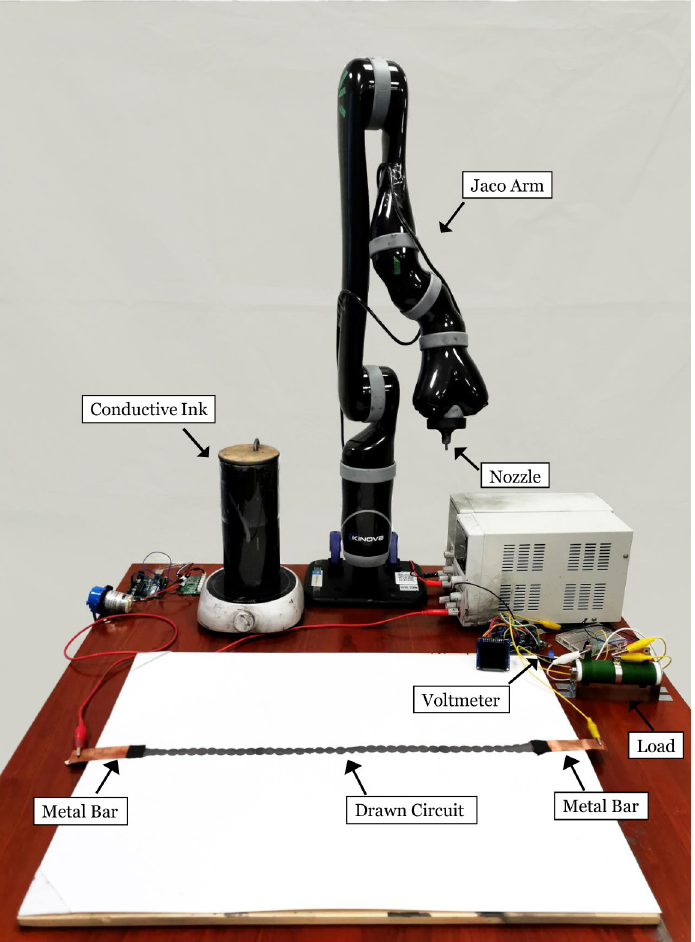
Fig 1. Experimental setup of the circuit drawing robot. The Kinova 6DOF Jaco Arm first moves to an initial Cartesian coordinate with the end-effector (nozzle) at 5 cm from the paper. The ROS controller sends instructions to both the arm and an Arduino to begin the circuit drawing. The circuit drawing movements are encoded as a list of Cartesian coordinates and sent to the arm. The Arduino then receives the state of the arm through ROS and sets the on/off of the peristaltic pump to control the ink flow. The robot draws a pattern on the cardboard connecting the two metal bars. The connection starts to show conductivity after the ink dries (30 minutes). A voltmeter is used to measure the load voltage as a feedback to optimize the drawing circuit. The load voltage is shown on an OLED display and the cardboard is replaced after each drawing.